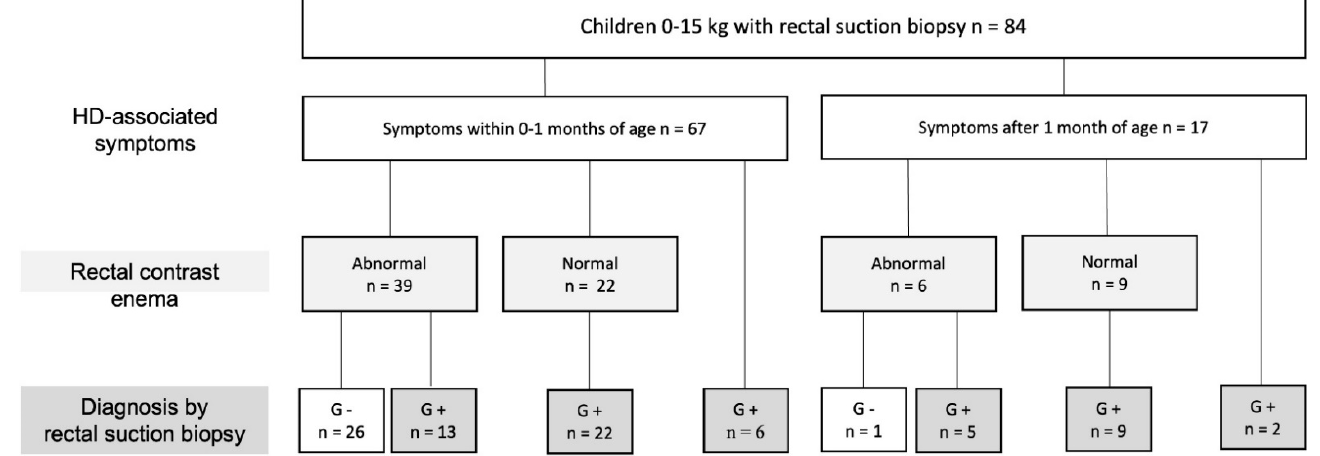
Figure 1. Diagnostic work up for children (n = 84) investigated for Hirschsprung’s disease (HD) with rectal suction biopsy. Aganglionosis (G − ) and ganglionosis (G+).